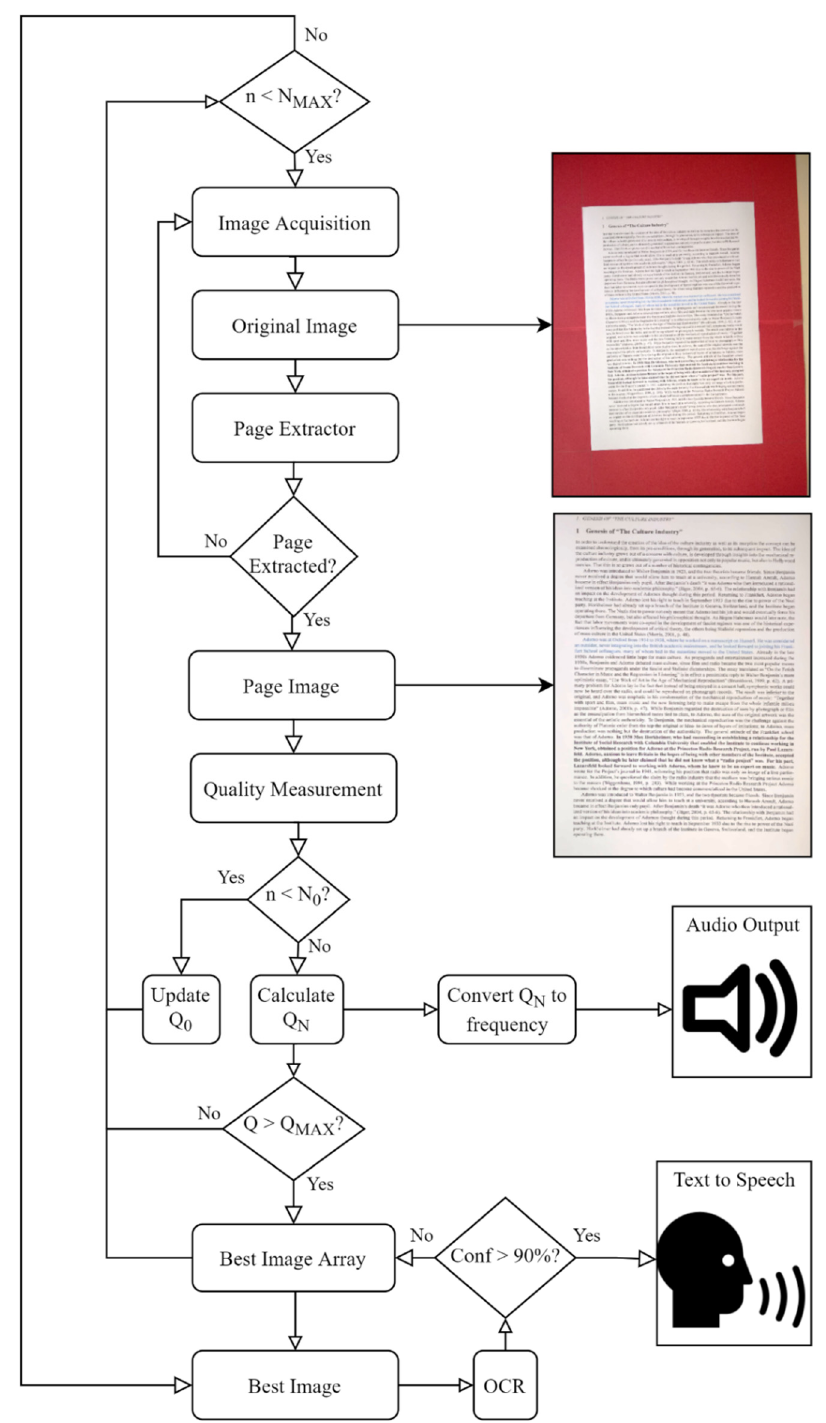
Figure 3. The workflow for the complete SEDIQA system; n = current image index, N MAX = maximum no. of images to be captured, N 0 = no. of baseline images to be captured, Q 0 = baseline Q , Q N = normalized Q , Q MAX = lowest Q in the Best Image Array, Conf = OCR confidence.